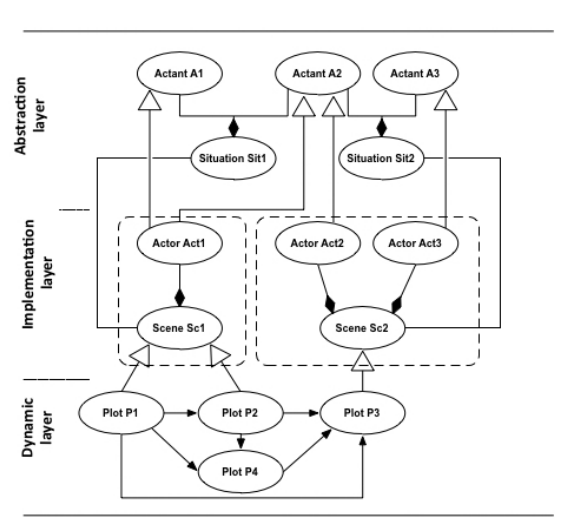
Figure 4. The situation based